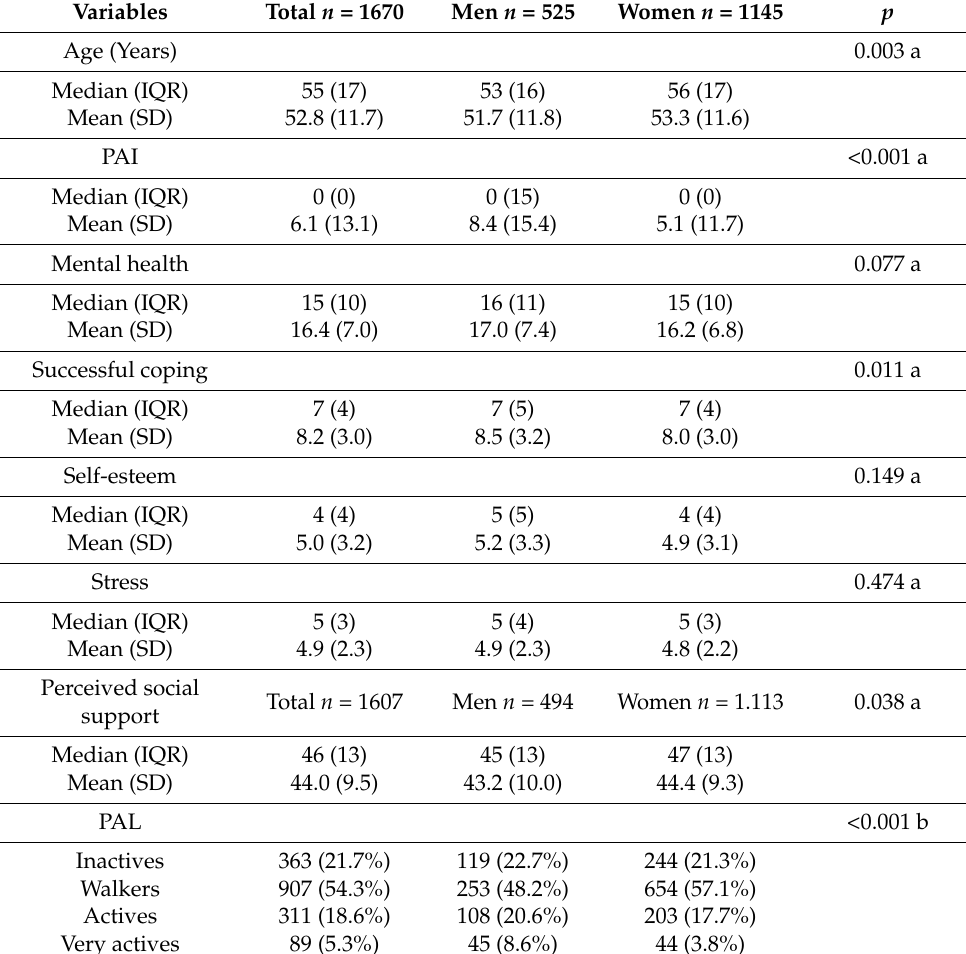
Table 1. Descriptive analysis includes age, physical activity index (PAI), the Goldberg General Health Questionnaire dimensions (GHQ-12), the Duke-UNC-11 Functional Social Support Questionnaire, and the PAL in Spanish adults with psychological distress, according to the ENSE 2017.